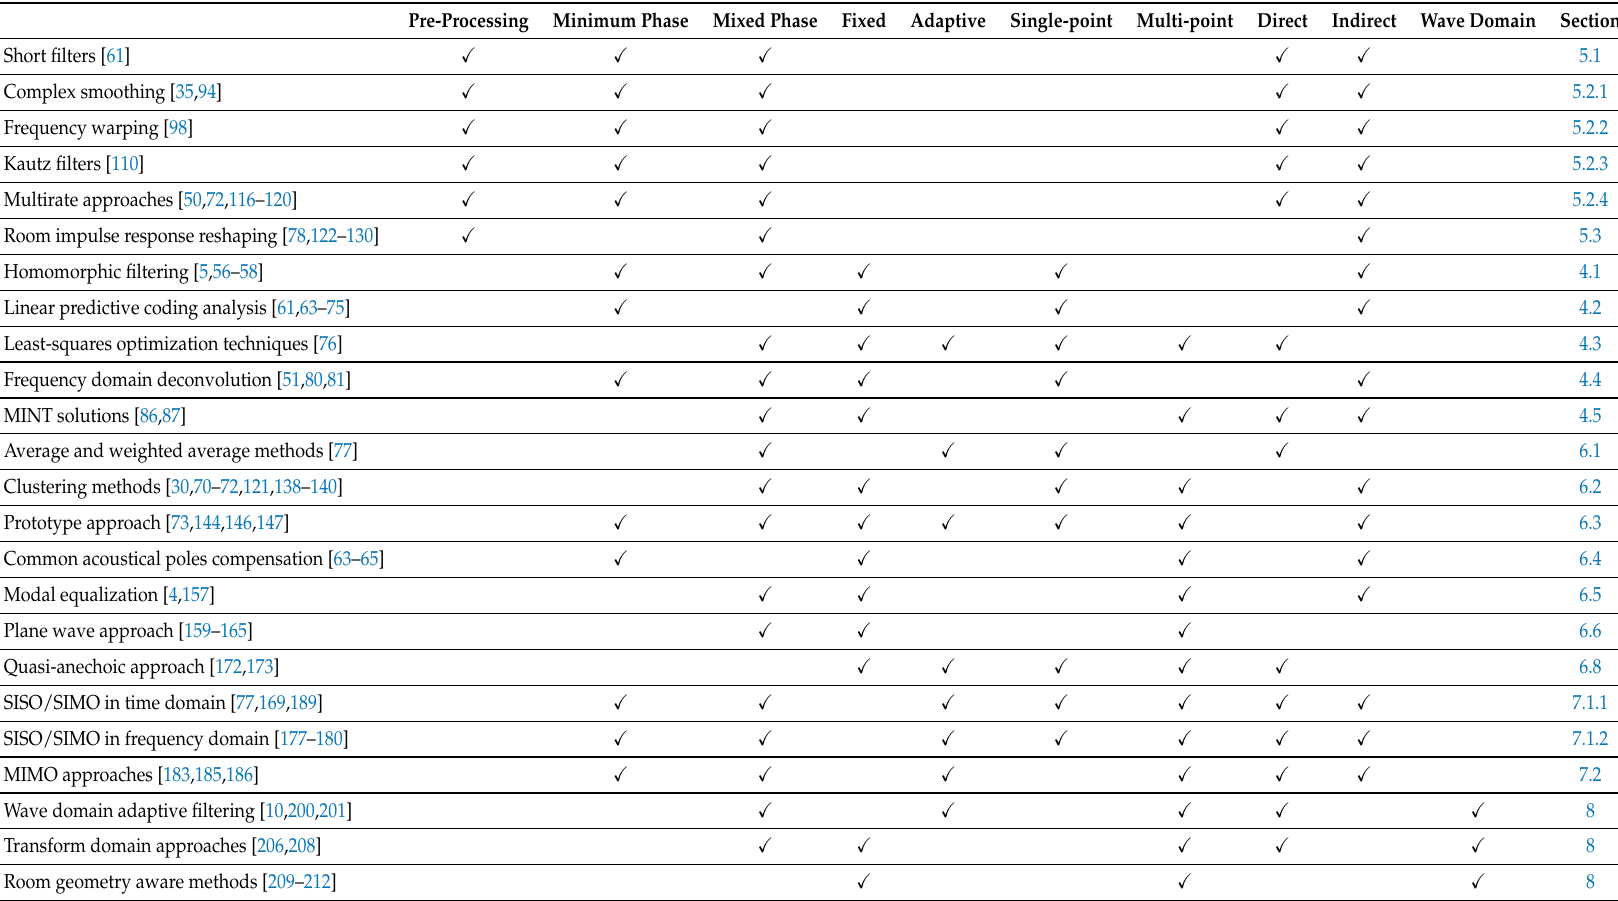
Table 1. Comparison of the state-of-the-art approaches considering the aforementioned classification criteria. MINT: multiple-input/multiple-output inverse theorem; SISO: single-input/single-output; SIMO: single-input/multiple-output; MIMO: multiple-input/multiple-output. Pre-Processing Minimum Phase Mixed Phase Fixed Adaptive Single-point Multi-point Direct Indirect Wave Domain